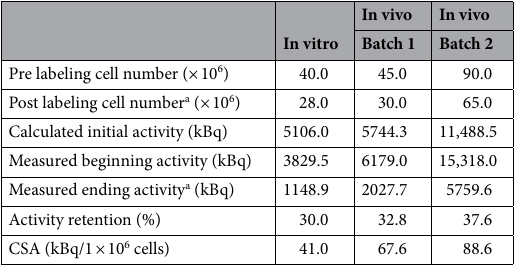
Table 1.. 89 Zr-oxine labeling activity retentions and cell specific activities (CSA). a 1 h after measured beginning activity.